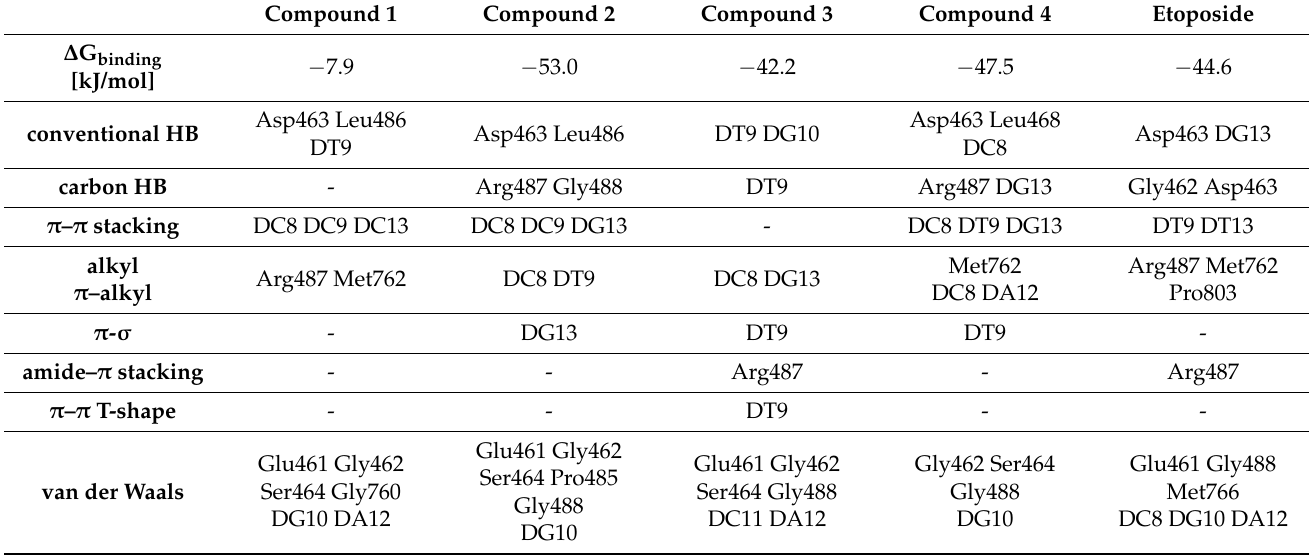
Figure 10. Free energy of binding and intermolecular interactions in the active site of topo II α (2D representation) of: ( a ) compound 1 ; ( b ) compound 2 ; ( c ) compound 3 ; ( d ) compound 4 ; ( e ) etoposide. A summary is presented in Table 4. Table 4. Free energy of binding and intermolecular interactions of designed compounds with topoisomerase II α in complex with DNA.